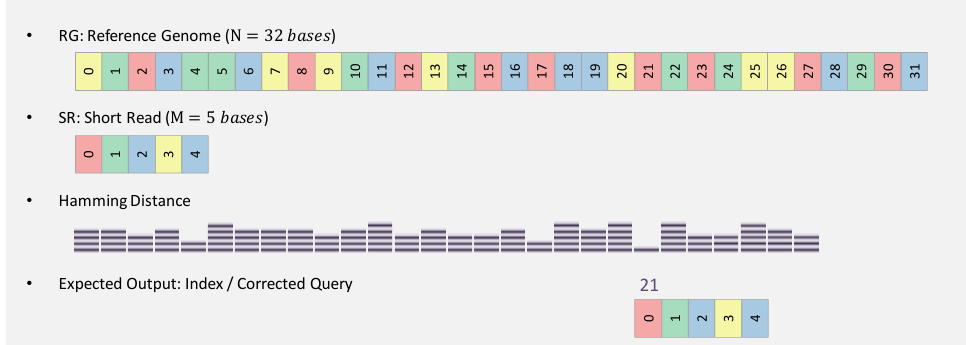
Figure 2. DNA sub-sequence alignment problem.